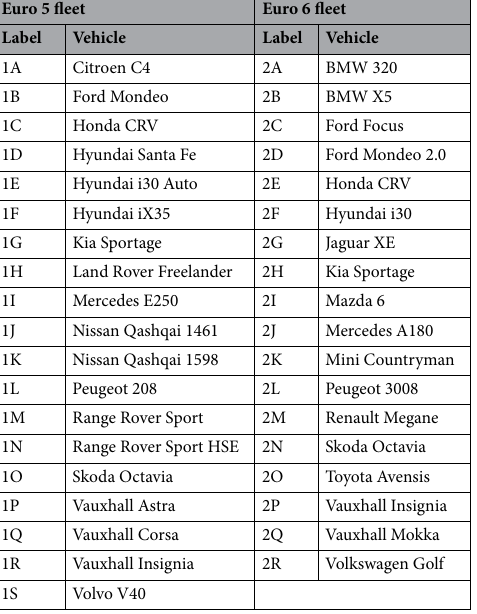
Table 2. Labelling of Euro 5 and Euro 6 vehicles for Fig.